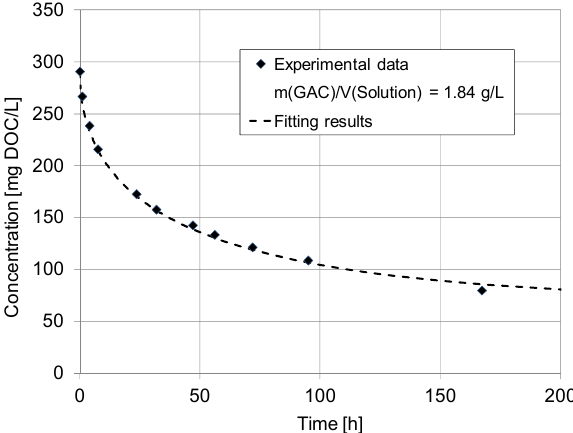
Figure 4. Data from a batch test with pre-treated HTC spent grains PW and fit of the film-homogeneous diffusion model.